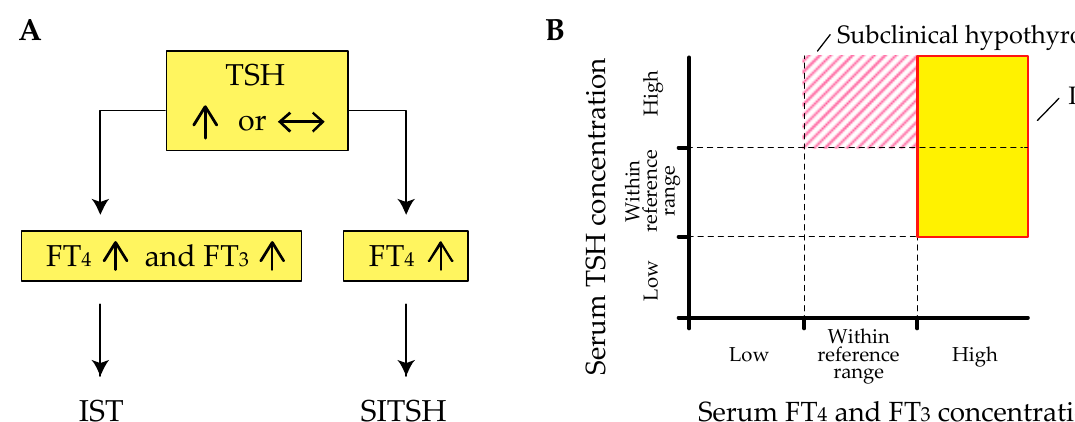
Figure 1. The different hormone profiles of inappropriate secretion of thyroid-stimulating hormone (IST) and syndrome of IST (SITSH). ( A ) A schematic explanation of the difference between IST and SITSH. Note that an elevated free triiodothyronine (FT 3 ) concentration is a requisite diagnostic criterion for IST. ( B ) A schematic explanation of the difference between IST and subclinical hypothyroidism. The shaded region and striped region represent the areas of IST and subclinical hypothyroidism, respectively. FT 4 , free thyroxine.